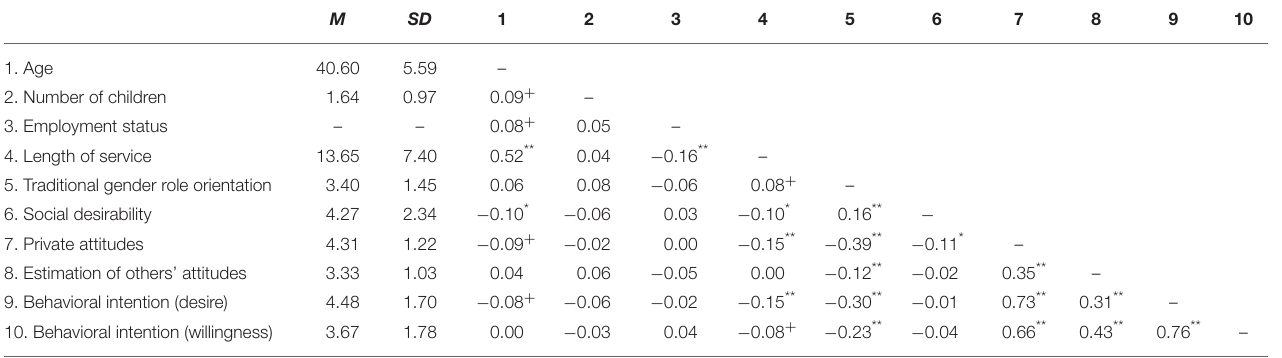
TABLE 2 | Descriptive statistics and zero-order correlations in Study 2.